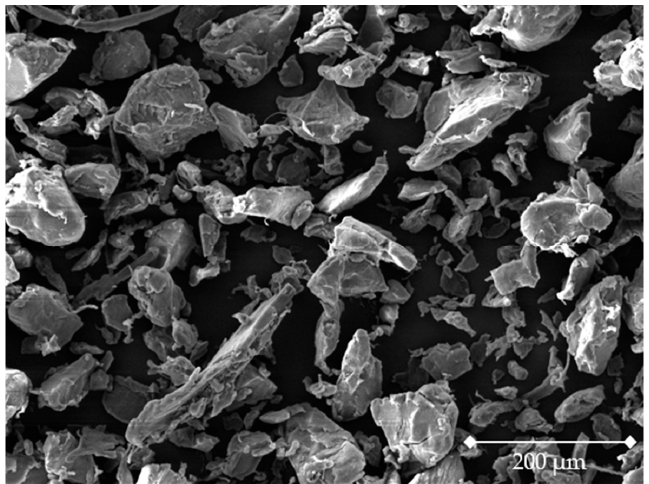
Figure 1. SEM image of the used sinter material. Produced with Tescan Mira 3 at 150× magnification.